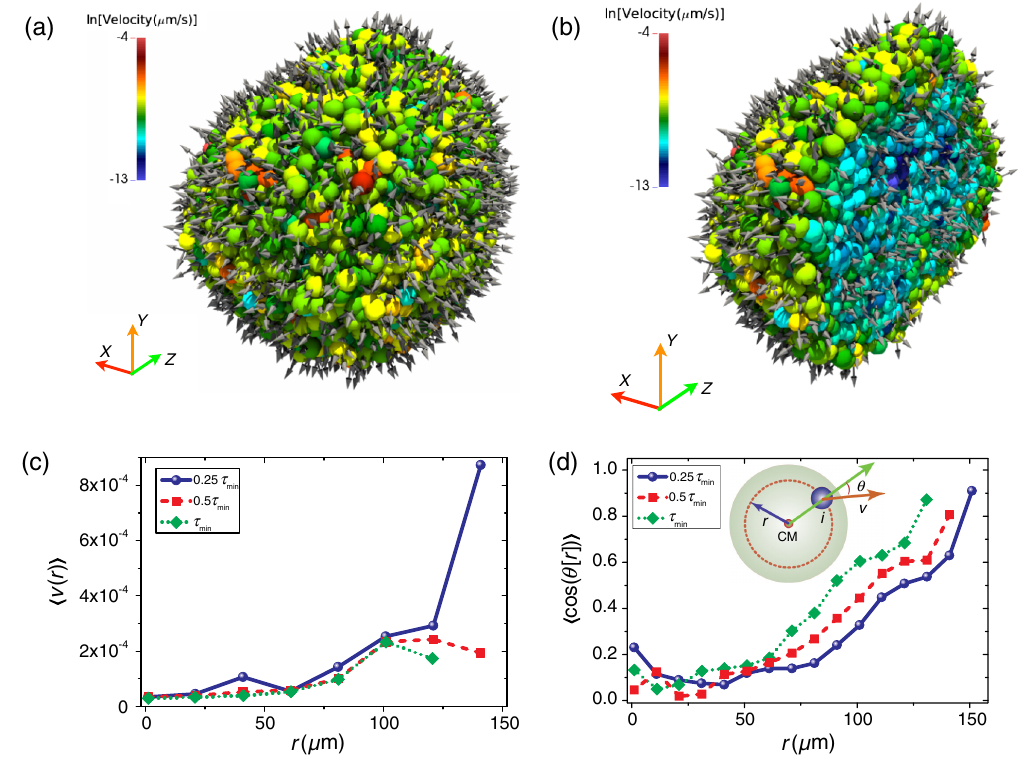
FIG. 14. Heterogeneity in the tumor cell dynamics. (a) Instantaneous snapshot of a collection N ≈ 1 . 3 × 10 4 cells at approximately 3 days with τ ¼ 0 . 25 τ . Colors indicate the different velocities of the individual cells (in μ m = s). (b) Cross section through the clump of min cells shown in Fig. 14(a). Arrows denote the direction of velocity. (c) Average speed of the cells as a function of the tumor radius at different τ . Observation time is at 18 . 5 τ , 14 . 8 τ , and 11 . 1 τ for τ ¼ 0 . 25 τ , 0 . 5 τ , and 1 τ , respectively. (d) Mean angle θ (see the min min min inset figure) between cell velocity and a line through the center of the tumor to the periphery as a function of the tumor radius at different τ . Observation time is the same as in